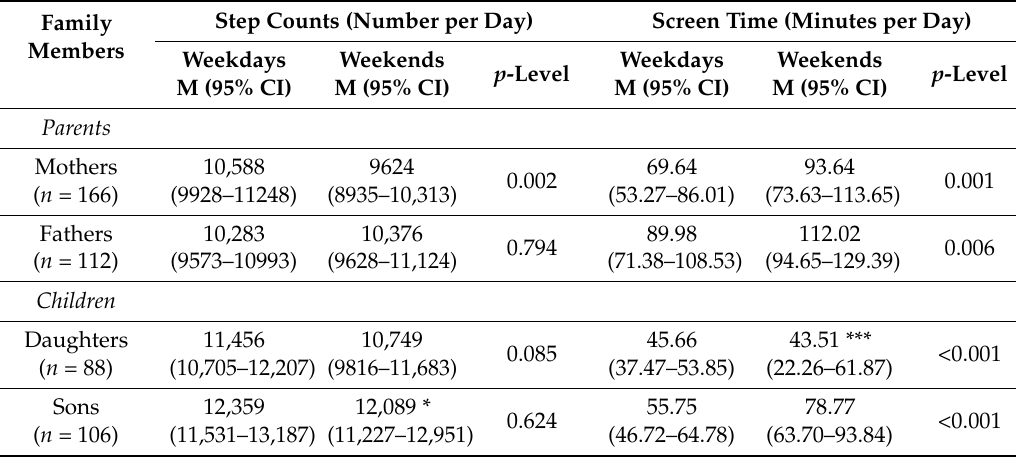
Table 2. Weekday-weekend patterns of daily step counts and screen time (mean and 95% CI) in parents and their preschool